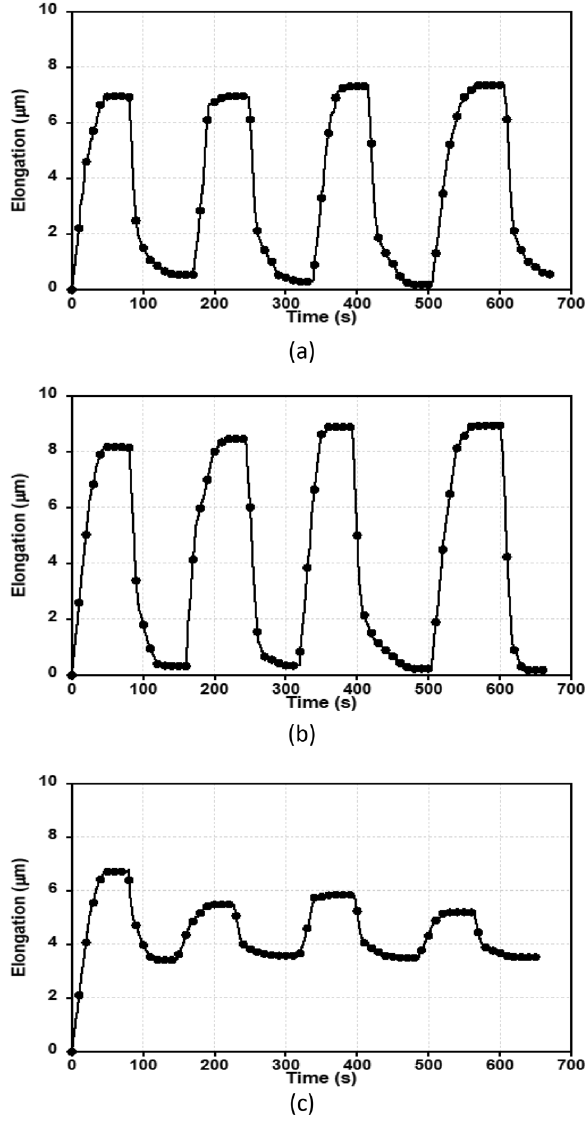
Figure 3. Experimental studies on cell viability for electrode voltages: ( a ) 8 V ( b ) 12 V ( c ) 16 V. In these figures, the elongation of cells is drawn versus time. At voltage 8 and 12 V, the cells have reversible and repeatable elongation. However, the cells at voltage 16 V, do not reverse to its original shape after turning off the applied